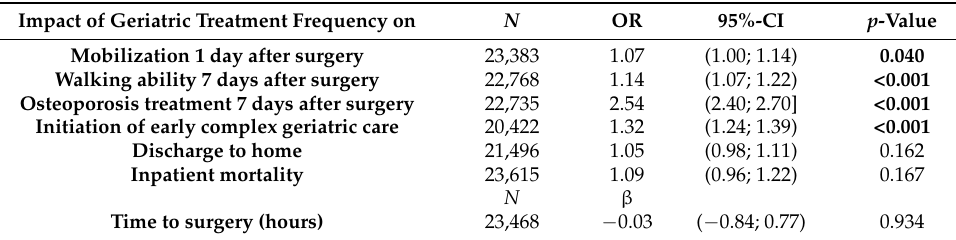
Table 2. Multivariable logistic and linear regression analysis of the impact of increased geriatric treatment frequency on various outcomes during the initial hospital stay.